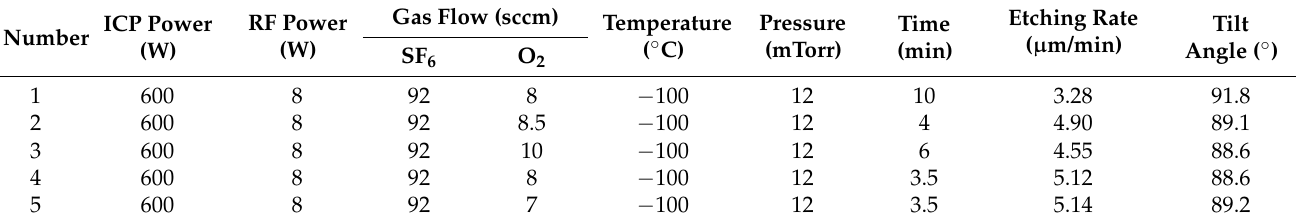
Table 3. Cryogenic process etching parameters and